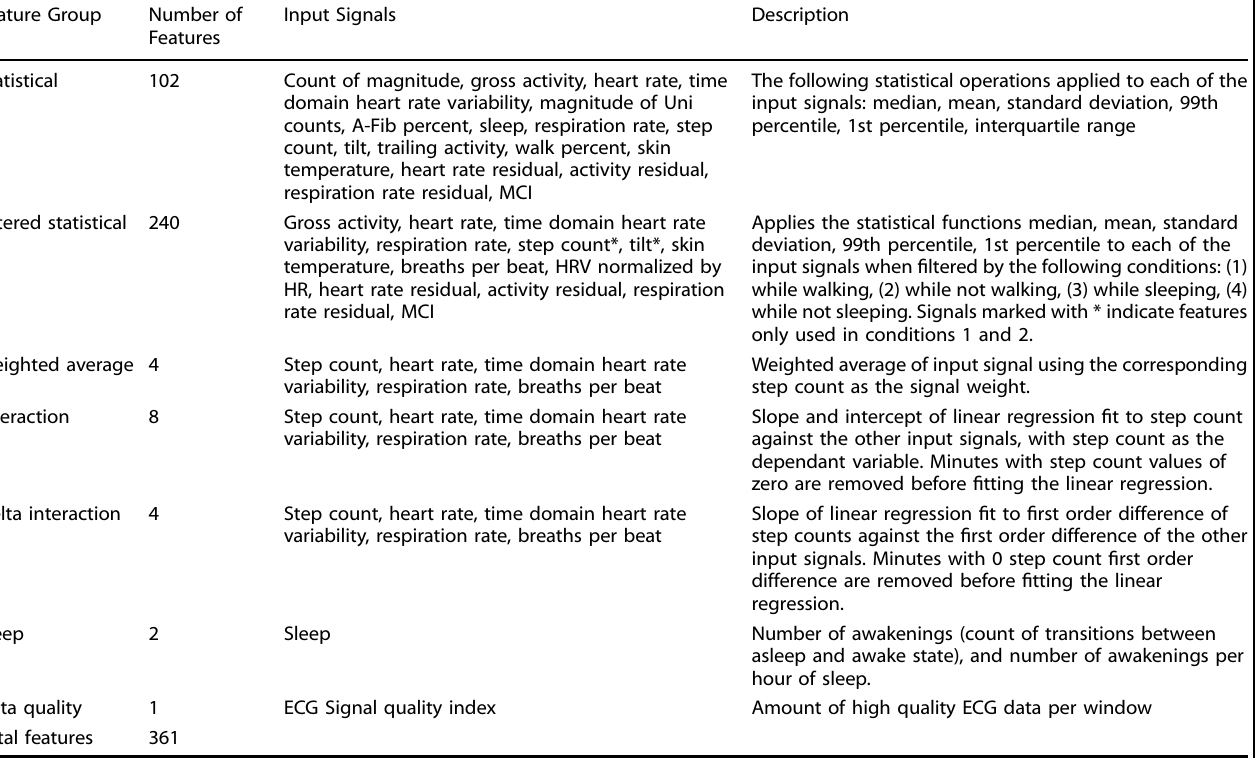
Table 4. Feature extraction transforms from 17 source signals to 361